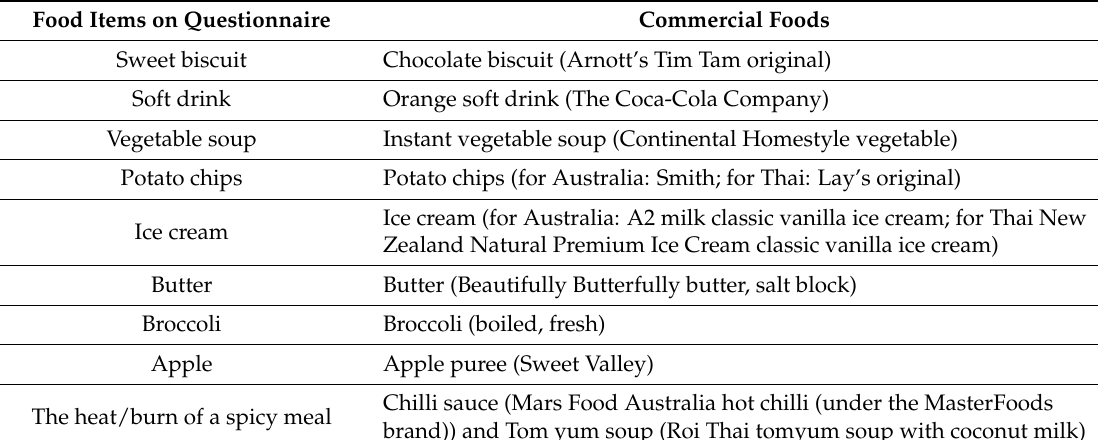
Table 1. Food items on the questionnaire and commercial foods. Food Items on Questionnaire